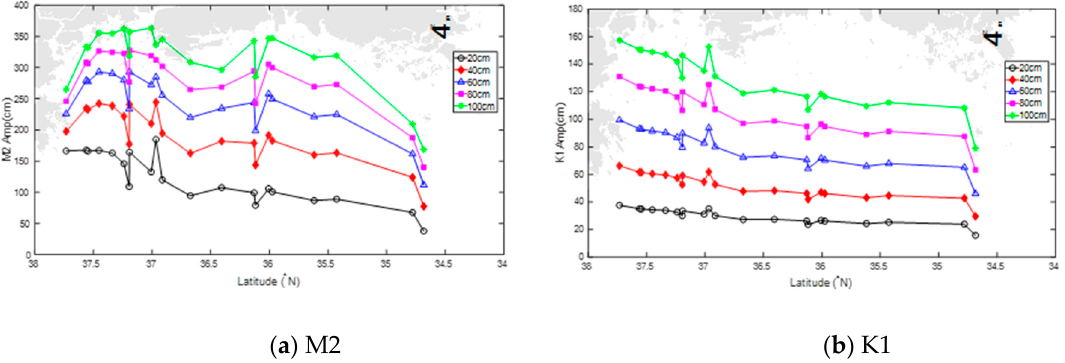
Figure 11. M2 and K1 amplitudes at gauge locations with respect to the forcing with the amplitudes of 20, 40, 60, 80 and 100 cm at the open boundary B; ( a ): M2’s amplitude; ( b ): M2’s